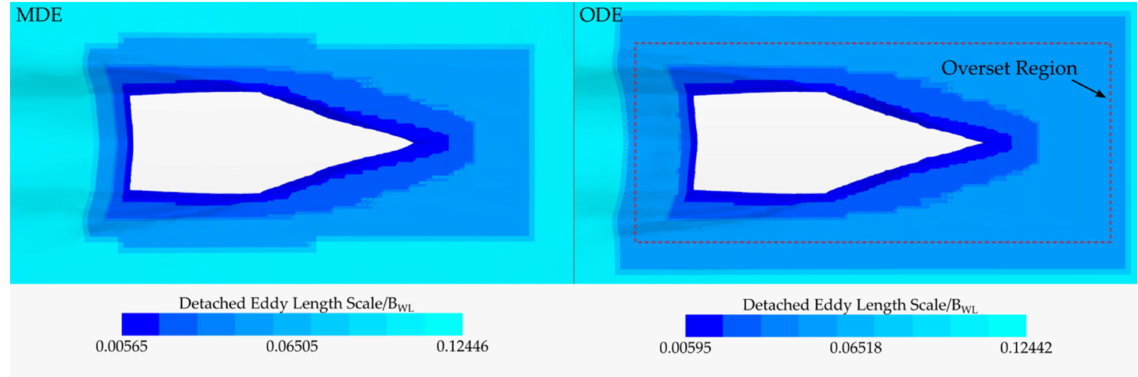
Figure 17. Detached eddy length scale around the vessel. Results correspond to the Froude Number of 2.59. Left and right panels, respectively, show the data related to MDE and ODE